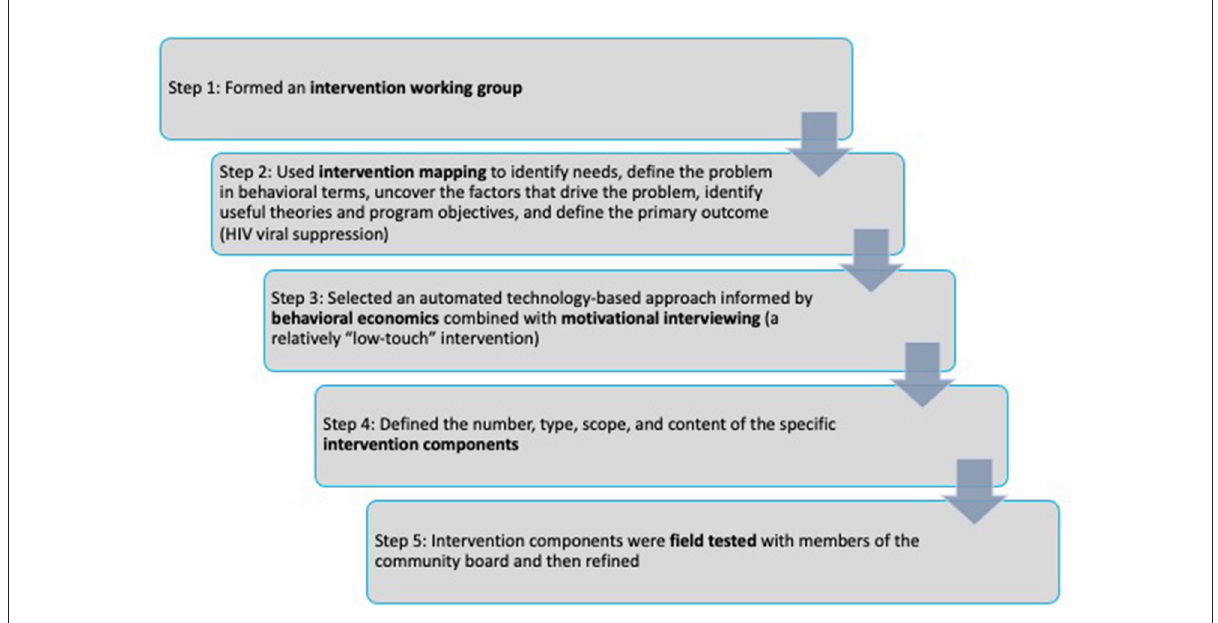
FIGURE1 Schematic describing the steps taken to develop the SCAP